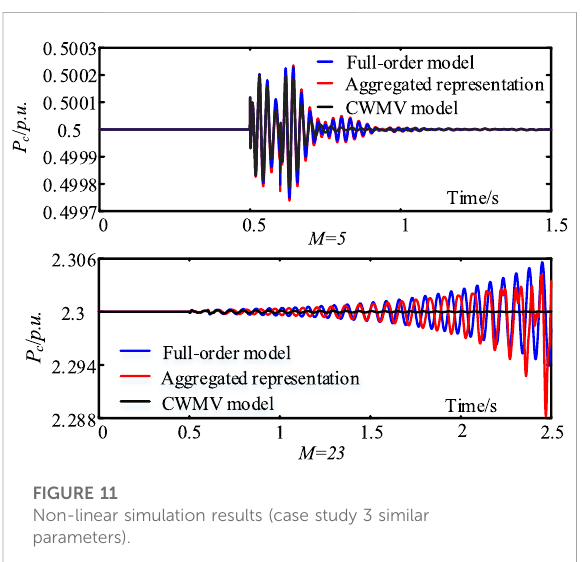
FIGURE 11 Non-linear simulation results (case study 3 similar